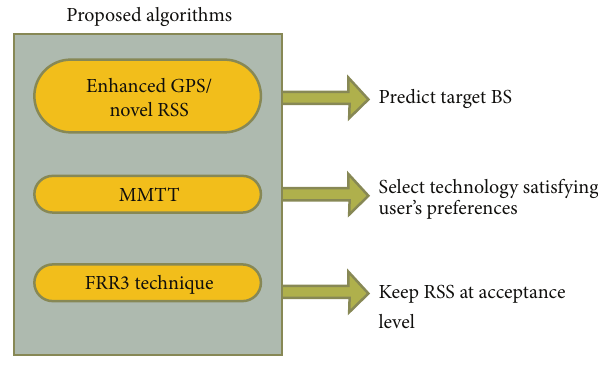
Figure 1: The system model.